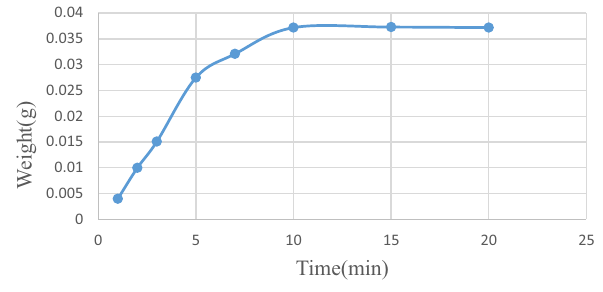
Fig. 8 Coating weight as a function of the time for the bioactive glass –YSZ composite